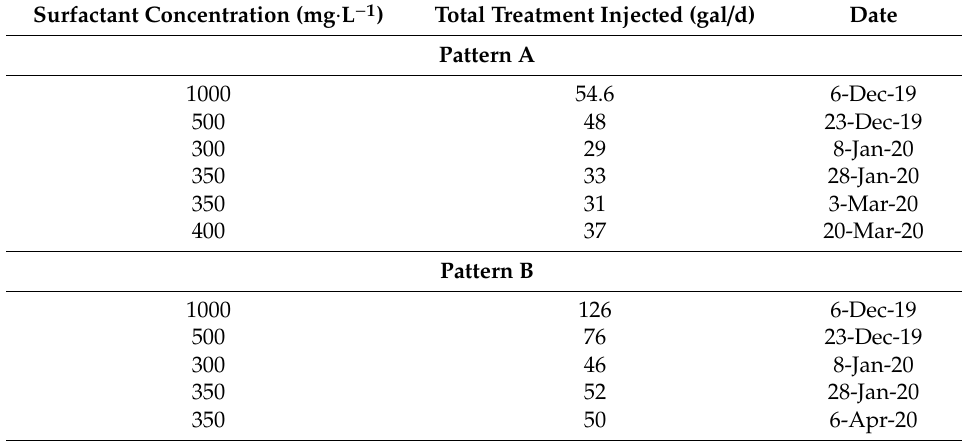
Table 3. Nanofluid flooding stage injection as a function of the surfactant concentration in the displacement fluid.